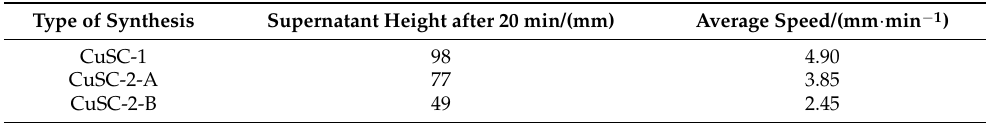
Table 5. Average settling velocity of alkaline copper carbonate suspensions within 20 min after the start of settling for different preparation methods.